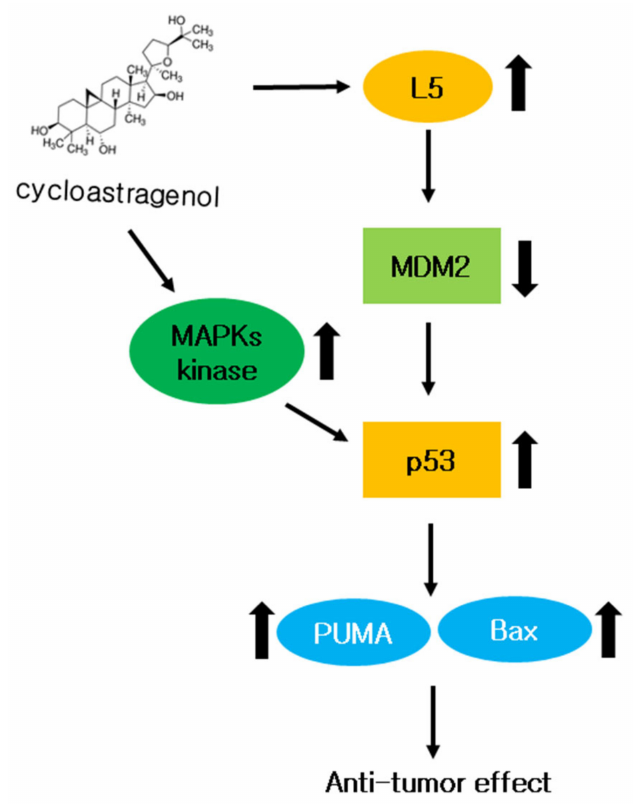
Figure 10. The role of CY in colon cancer cells. A mechanistic scheme showing how CY induces apoptosis by activating